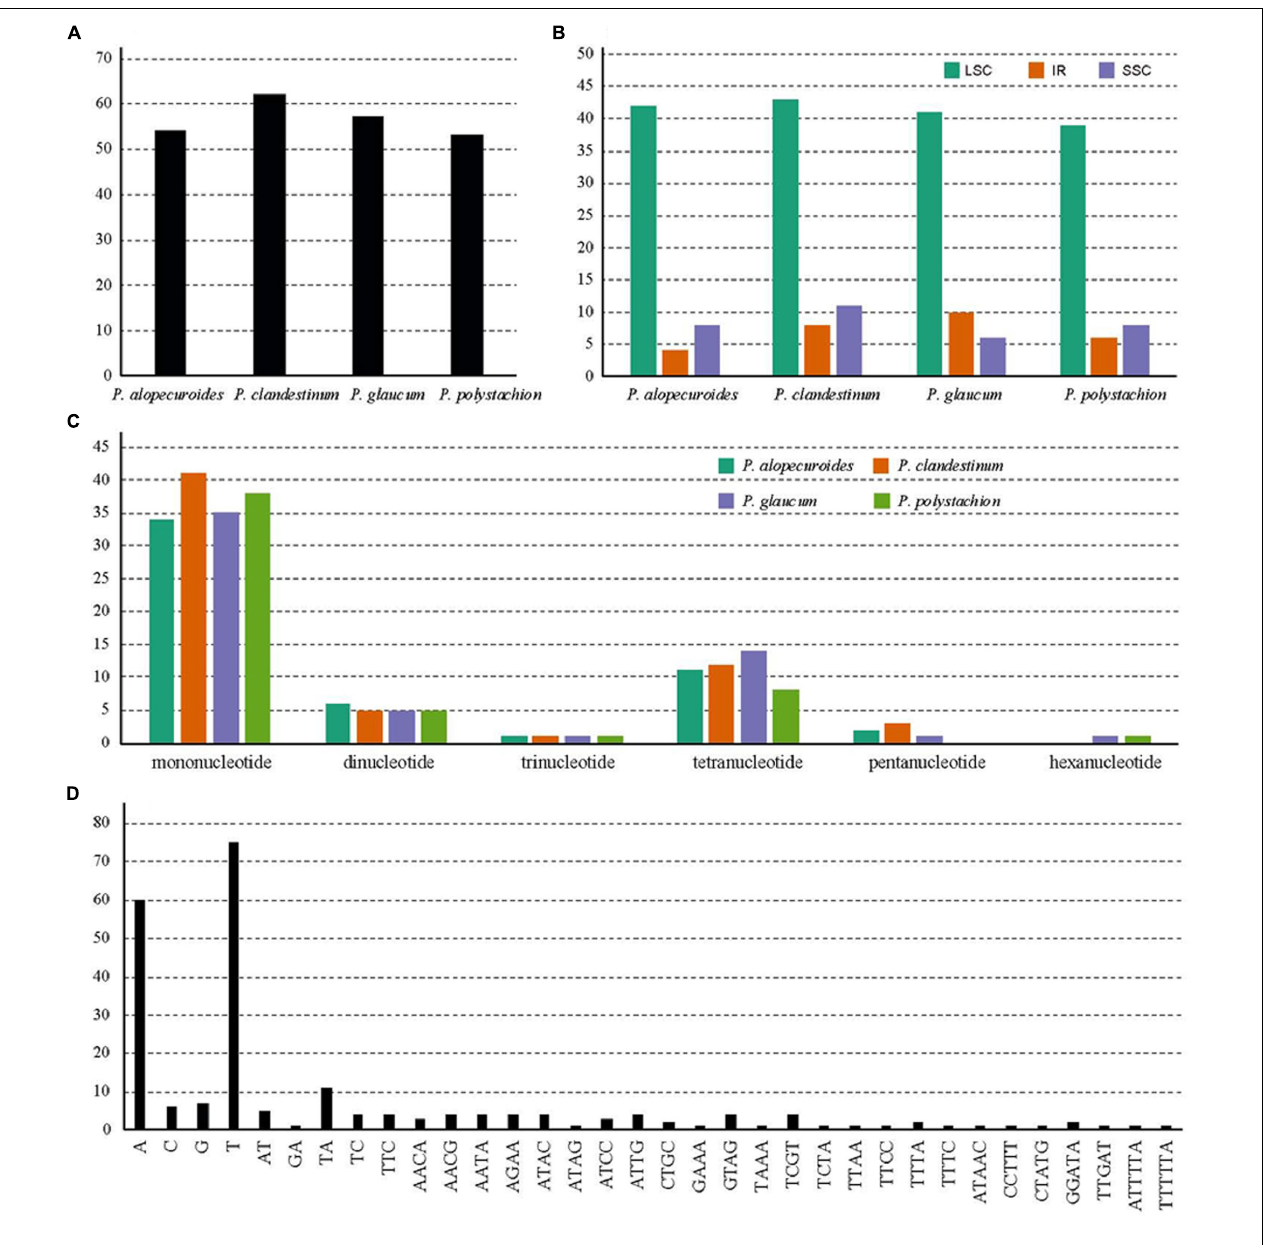
FIGURE 5 | Analysis of simple sequence repeats (SSRs) in four Pennisetum chloroplast genomes. (A) The number of SSRs detected in the four chloroplast genomes; (B) The number of SSRs in large single-copy (LSC), inverted repeat (IR), and small single-copy (SSC) regions in the four chloroplast genomes; (C) The number of SSR types detected in the four sequenced chloroplast genomes; (D) The frequency of identified SSR motifs in different repeat class types.